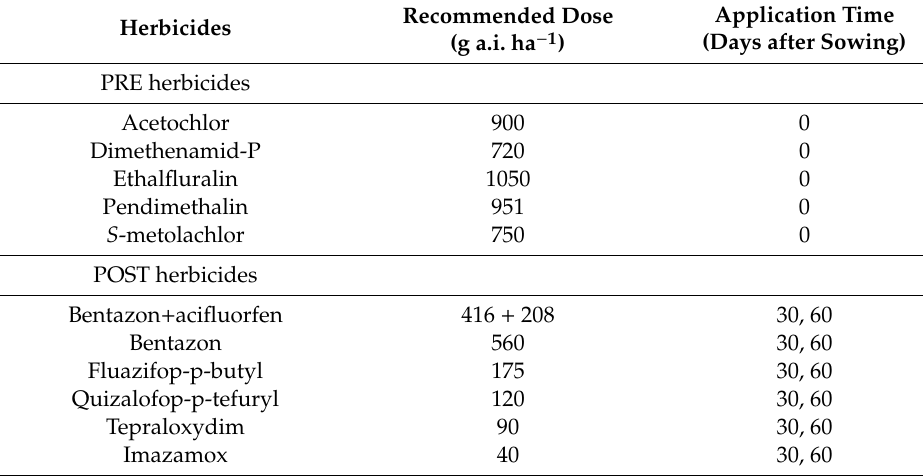
Application Time (Days after